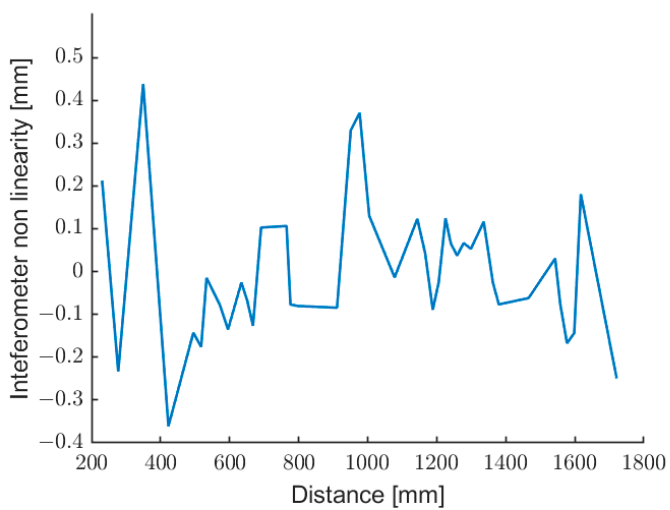
Figure 14. Difference between the measurements of the grating ruler and the optical sensor.